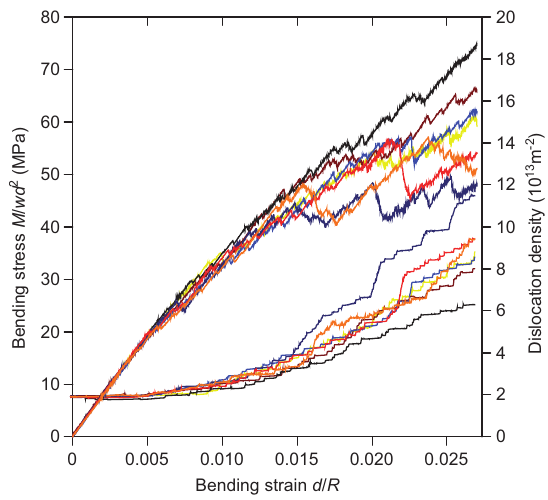
Figure 7 Discrete dislocation dynamics simulations of microbend- ing. Upper curves, scaled bending moment vs. total surface strain; lower curves, dislocation density vs. surface strain; [100]-oriented Al single crystals, specimen dimensions 0.75 × 0.75 × 1.5 μm.